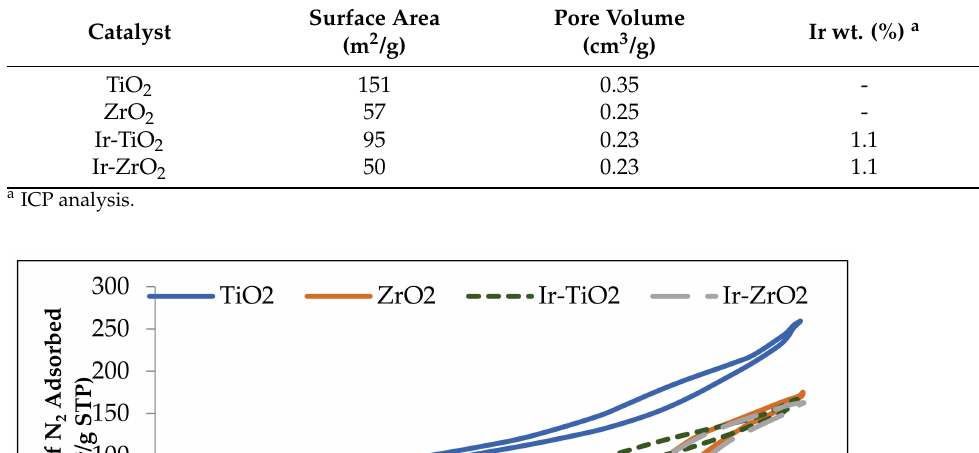
Table 1. BET and ICP data of the supported Ir catalysts.